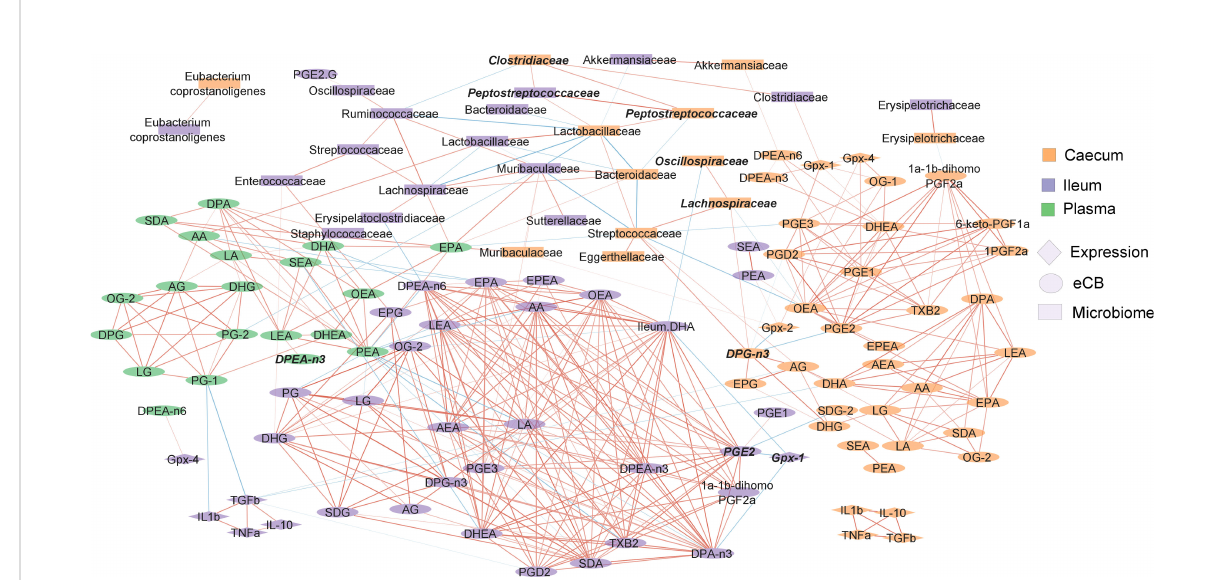
FIGURE 7 Correlation network showing the relationship between the endocannabinoidome, the gut microbiome and intestinal gene expression of immune and Gpx family genes. Color of the nodes indicate the tissue. Shape of the nodes indicate the type of data. The color of edges represents positive (red) or negative (blue) correlation. Width of the edges are proportional to the strength of the correlation. Features in bold italics were statistically signi fi cant between the depleted and enriched Se HFHS diet. The position of nodes was manually adjusted to improve